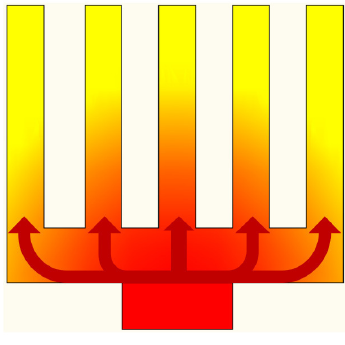
Figure 4. Scheme of heat spreading phenomenon in a PFHS: red and yellow represent high and low temperature regions, respectively; arrows represent heat propagation